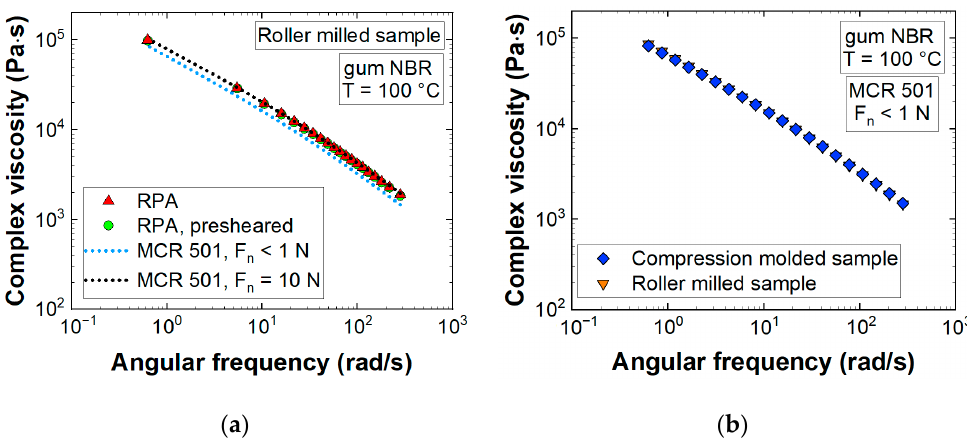
Figure 3. ( a ) Effect of applied normal force (F n ) on the sample during the measurement and influence of the measurement devices (RPA vs. MCR 501) on the complex viscosity of gum NBR; ( b ) No influence of sample preparation detected on the complex viscosity of gum NBR.